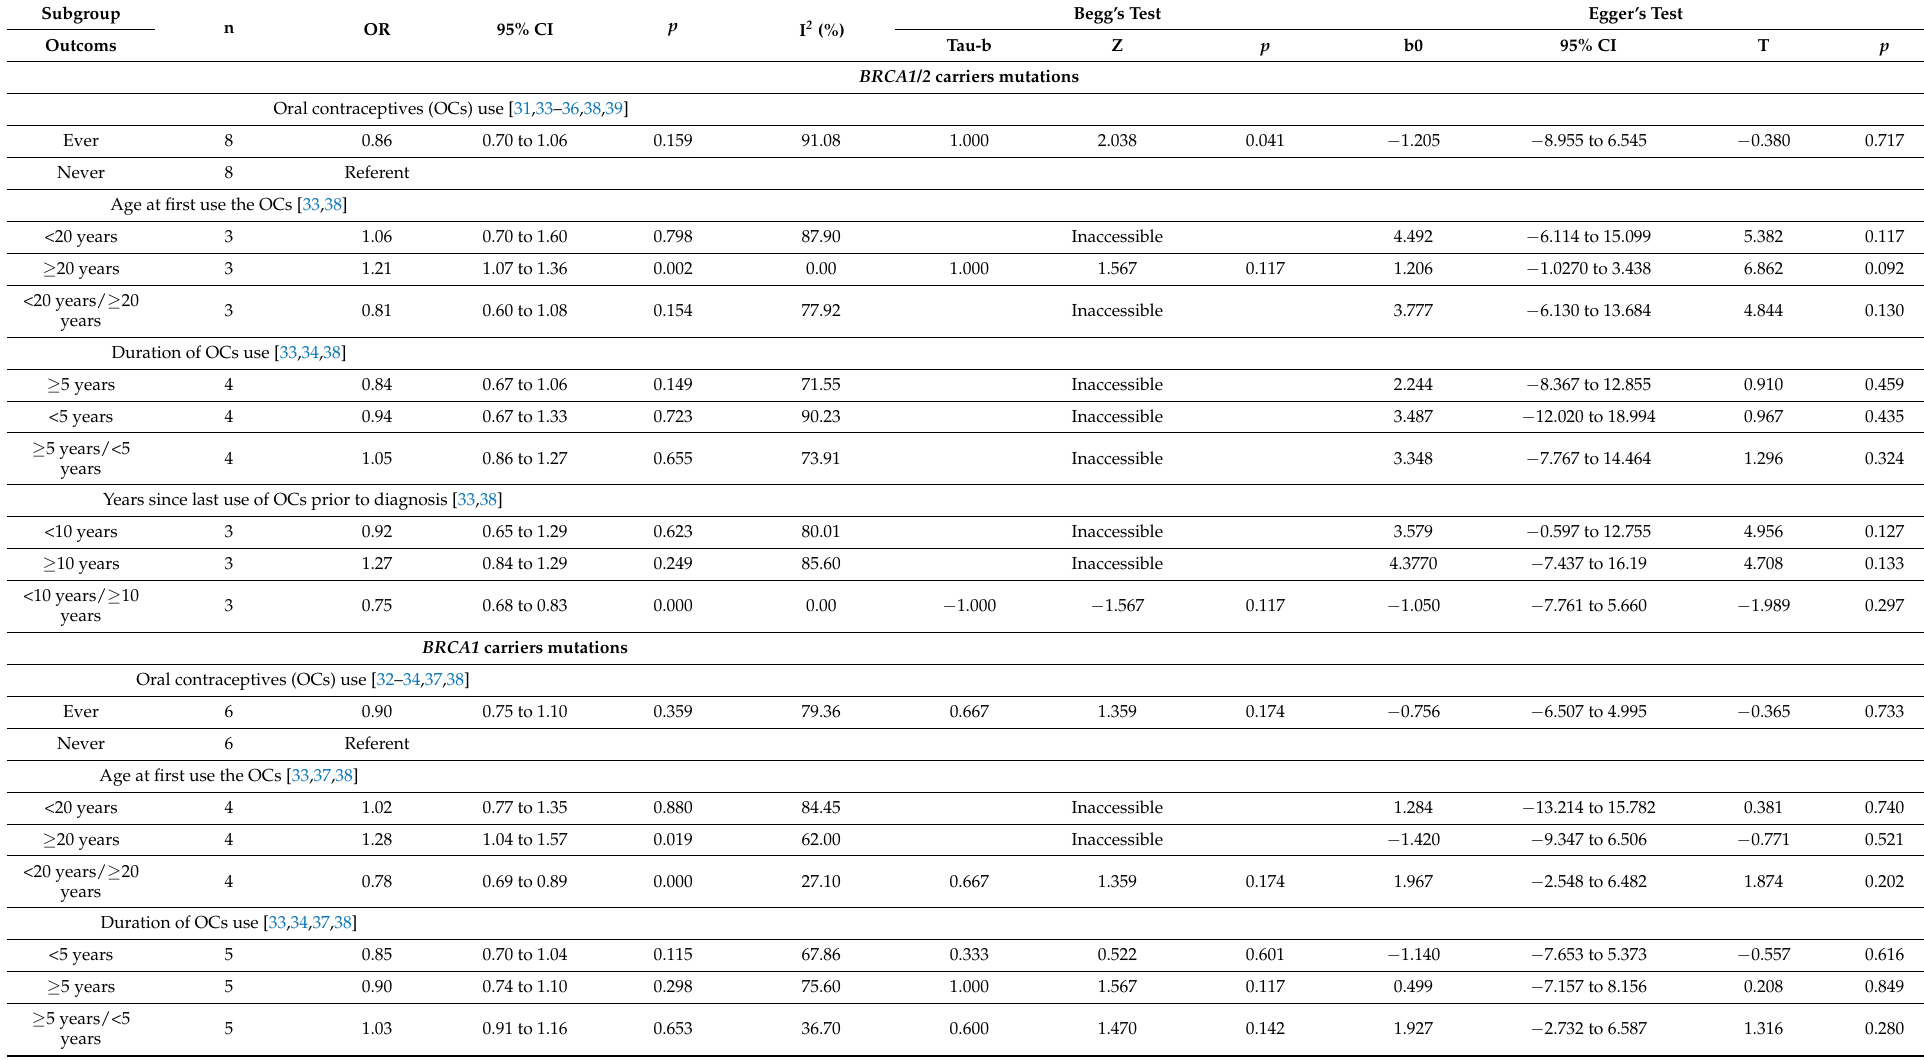
Table 2. Pooled estimates of effect of taking oral contraceptives on breast cancer